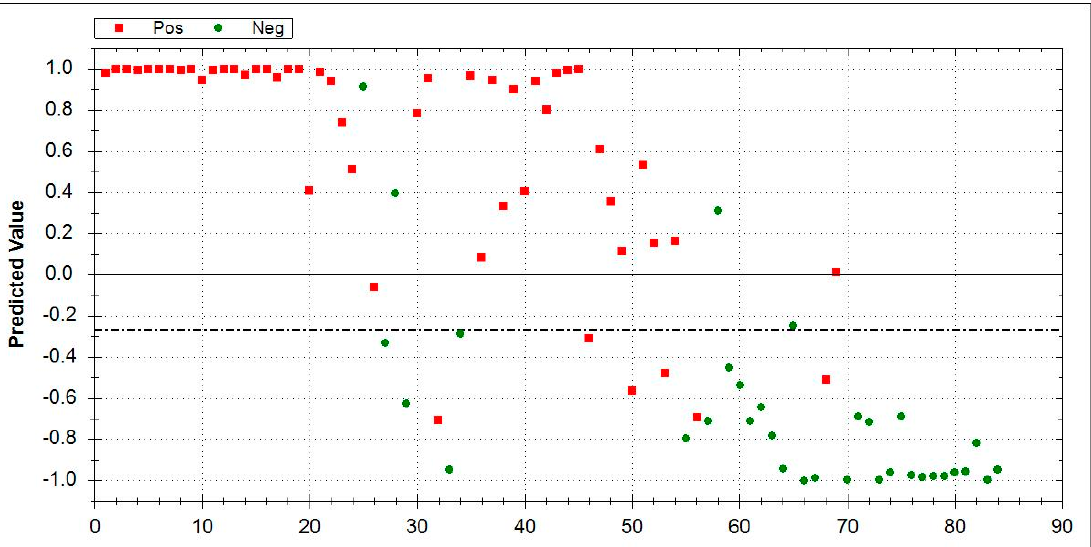
Figure 1. Direct comparison between idiopathic pulmonary fibrosis ( n = 51, red squares) and HC ( n = 33, green dots) by Aeonose ® . IPF area 0–1: Red squares indicate correctly recognized IPF patients. Green dots denote false positive patients. HC area 0– − 1: Green dots represent correctly identified healthy controls, and red squares mark false negative results. The dotted line is inserted for values around the threshold where there is doubt about which side it tends to, and, hence, reflects an area of uncertainty. Abbreviations: IPF-Idiopathic pulmonary fibrosis, HC- healthy controls. By directly comparing patients with CTD-ILD ( n = 25) vs. HC ( n = 33), an AUC of 0.90, MCC of 0.69, sensitivity of 0.84, and specificity of 0.85 were encountered. Figure 2 shows the ability of